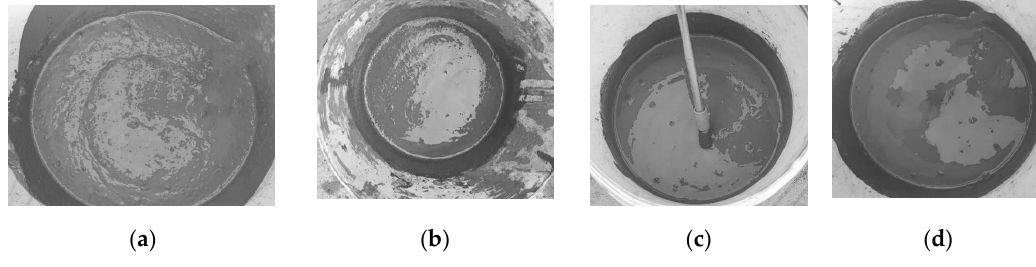
Table 1. Single layer flow test scheme and results.